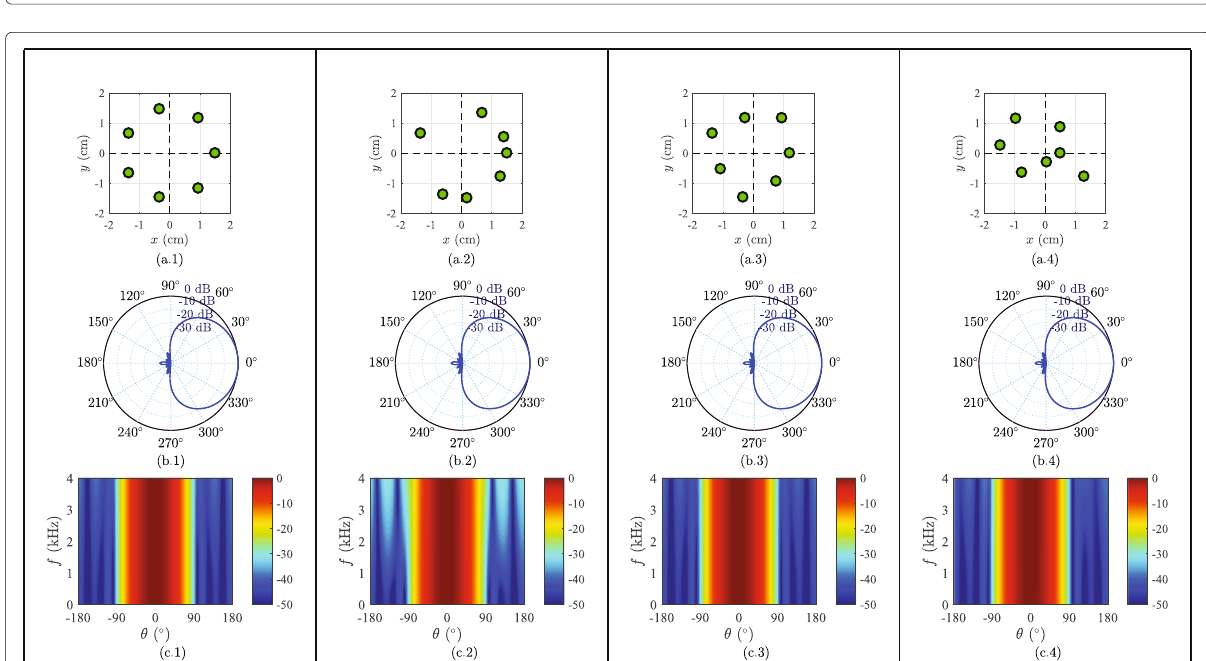
Fig. 7 DI and WNG of the second-order differential beamformer designed with four different array geometries for different look directions: a DI and b WNG